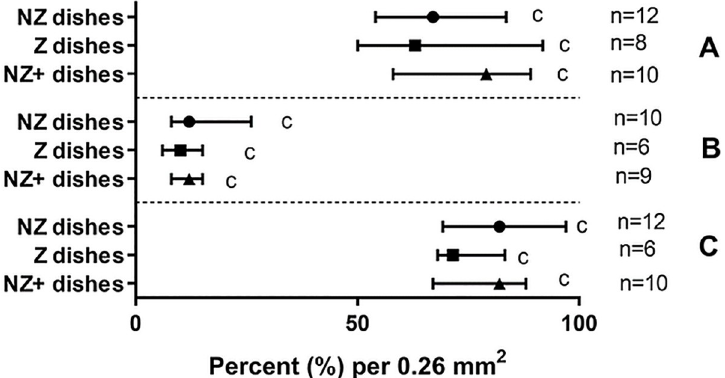
Fig 7. Viability, proliferation, and differentiation bioassay of 3-D endometrial cell structures. Percentages of viable cells (A), proliferating cells (B) or cytokeratin-rich epithelial cells (C) after two weeks of culture in different treatment groups (Median with IQR). Number of replicates for each treatment group are in parentheses. Matching lowercase letters indicate the absence of difference within each shape (P >